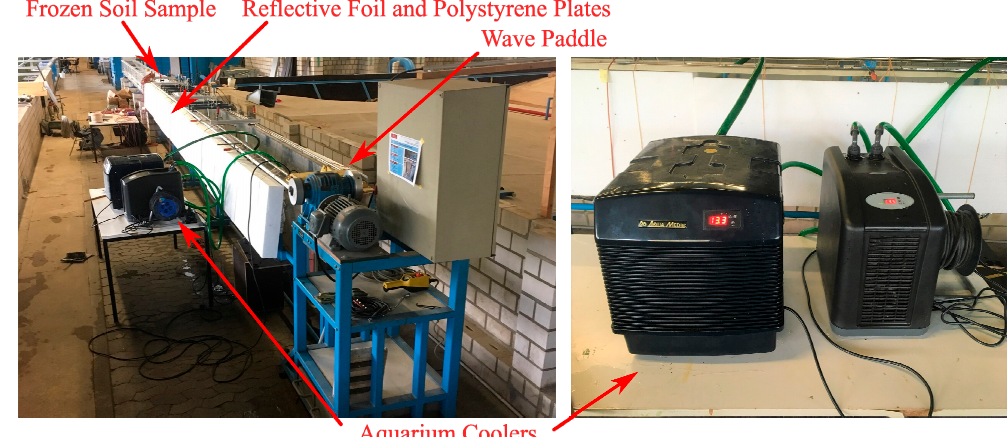
Figure 7. Reflecting foil, polystyrene plates and aquarium cooler (serial connection) for cooling the water and reducing heat flow. water and reducing heat